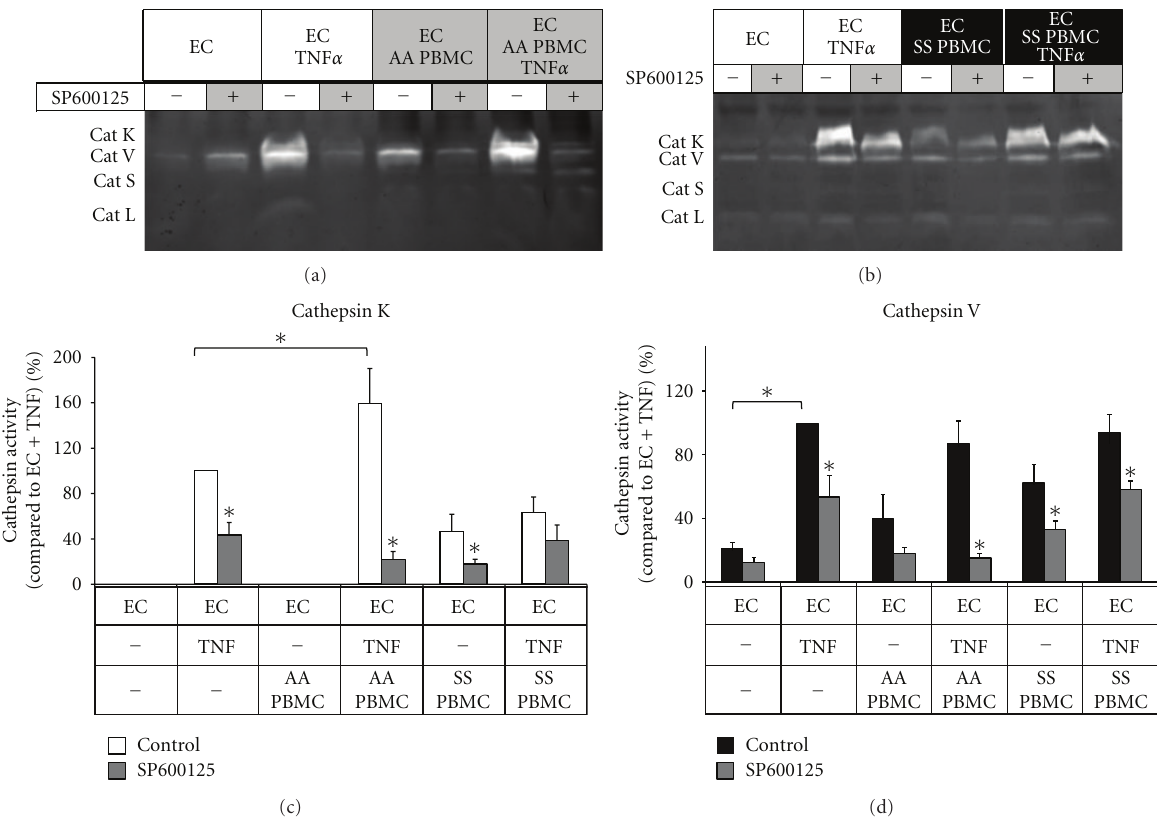
Figure 3: Cathepsins K and V activities induced by sickle cell disease PBMCs are significantly reduced by JNK inhibition with SP600125. HAECs were incubated with or without 10 μ M of the JNK inhibitor, SP600125, 1 hour prior to TNF α stimulation, as described previously. Cocultures with AA or SS PBMCs were maintained for an additional 20 hours. Cell lysates were collected and analyzed via multiplex cathepsin zymography. Densitometric analysis quantified active cathepsins K and cathepsin V ( n = 3, ∗ P < 0 . 05, SEM bars